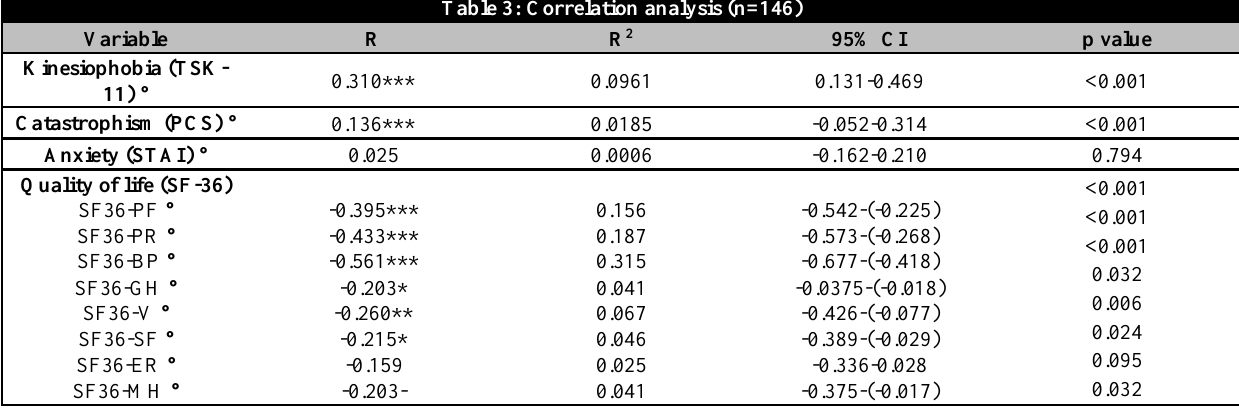
Table 3: Correlation analysis